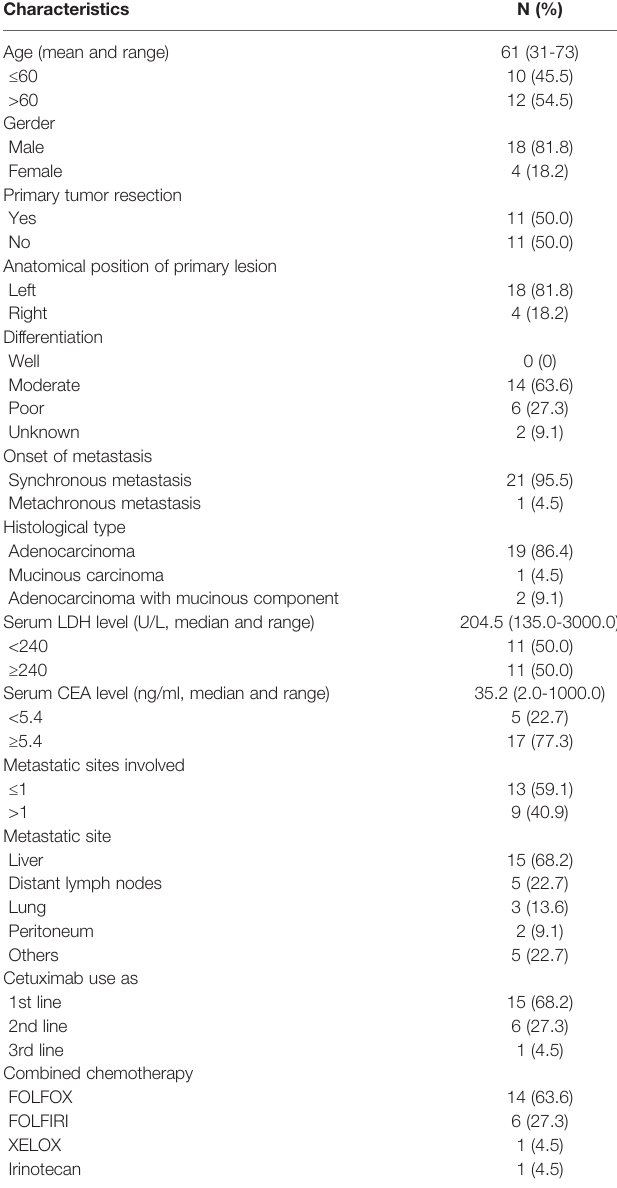
TABLE 1 | Baseline patients ’ characteristics (n=22 a